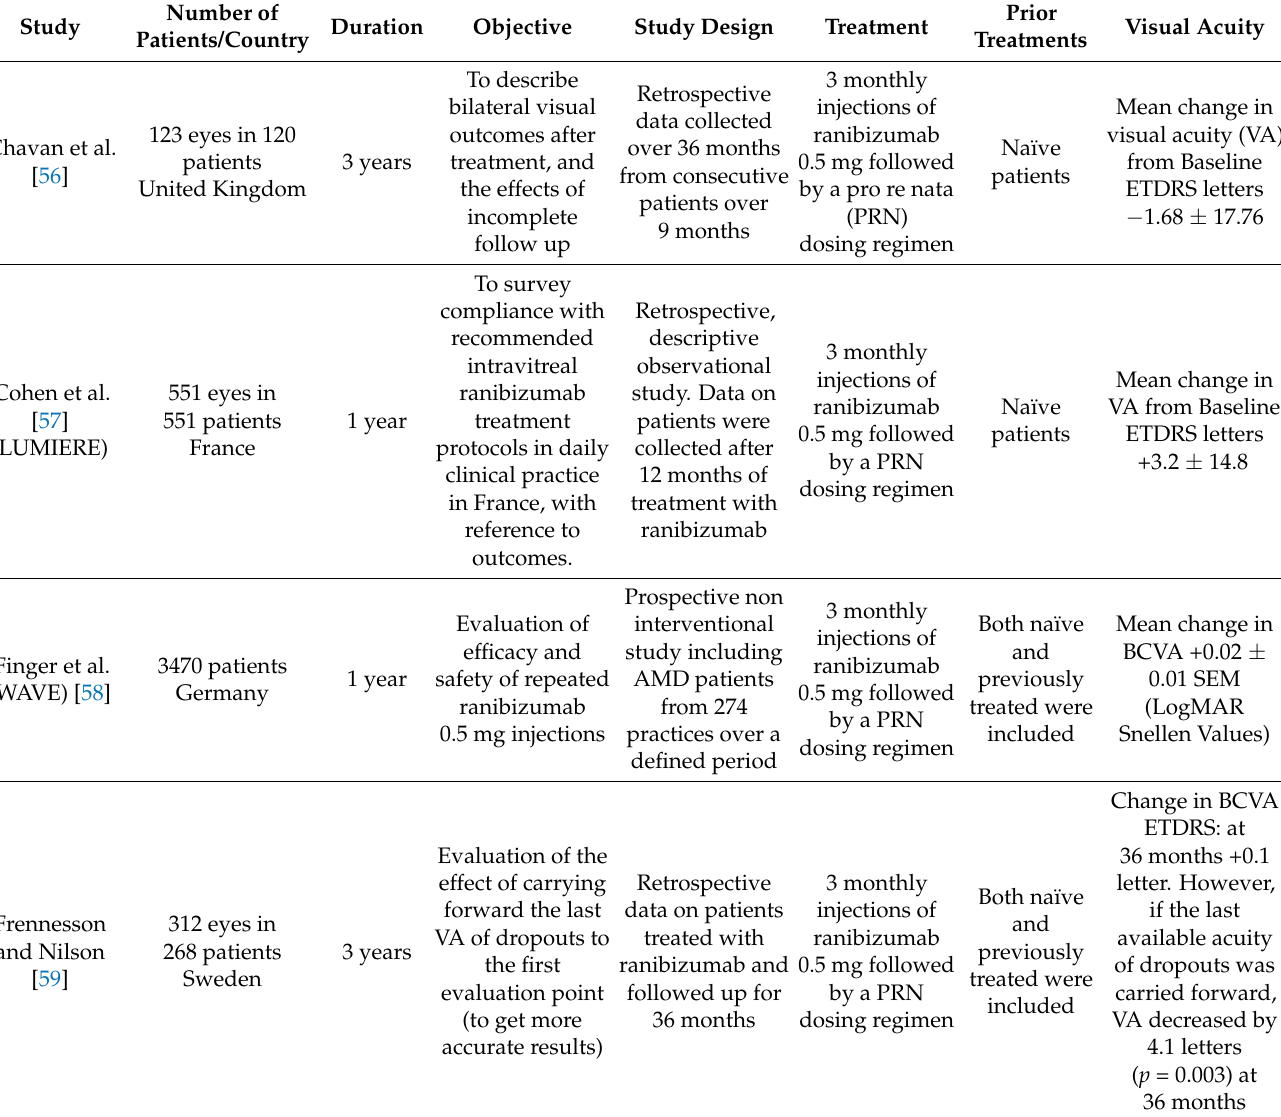
Table 2. Summary of real-world studies evaluating the efficacy of ranibizumab in the management of neovascular age-related macular degeneration